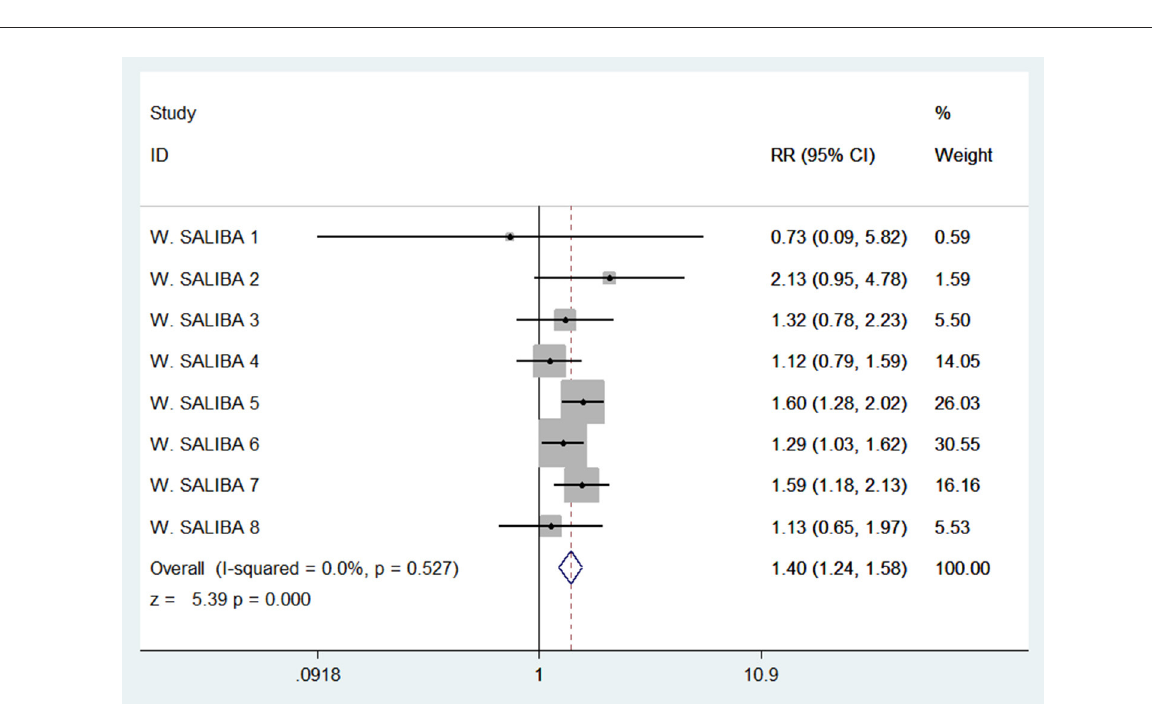
FIGURE4 Forest plot of associations between stroke incidence and NLR levels in patients with